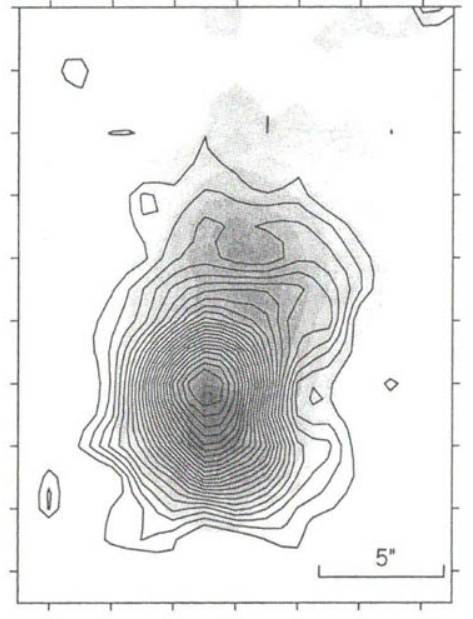
Fig. 3. Restored image of Bernes 48 in the continuum (gray scale) and [S II]